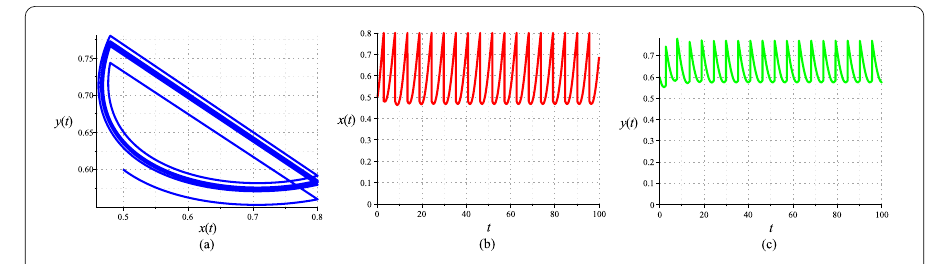
Figure 9 Numerical simulations in Case II. ( a ) Phase portrait of x ( t ) and y ( t ) on h = 0.8. ( b ) Time series of x ( t ). ( c ) Time series of y ( t